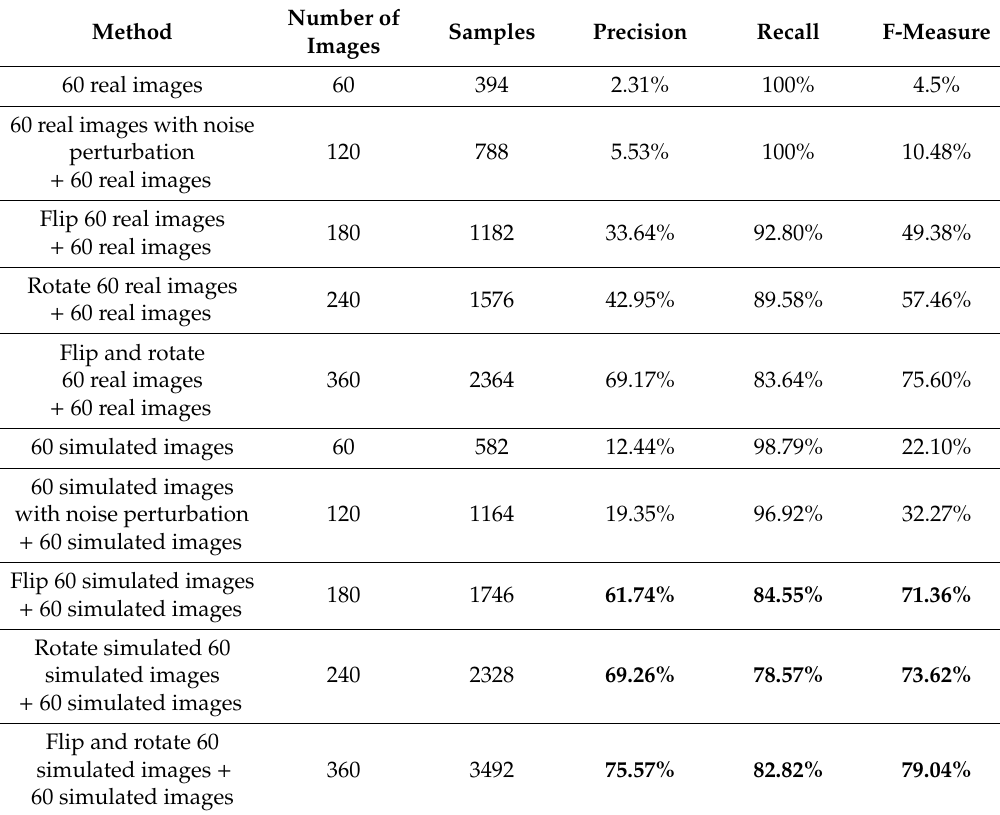
Table 2. The results with di ff erent training image